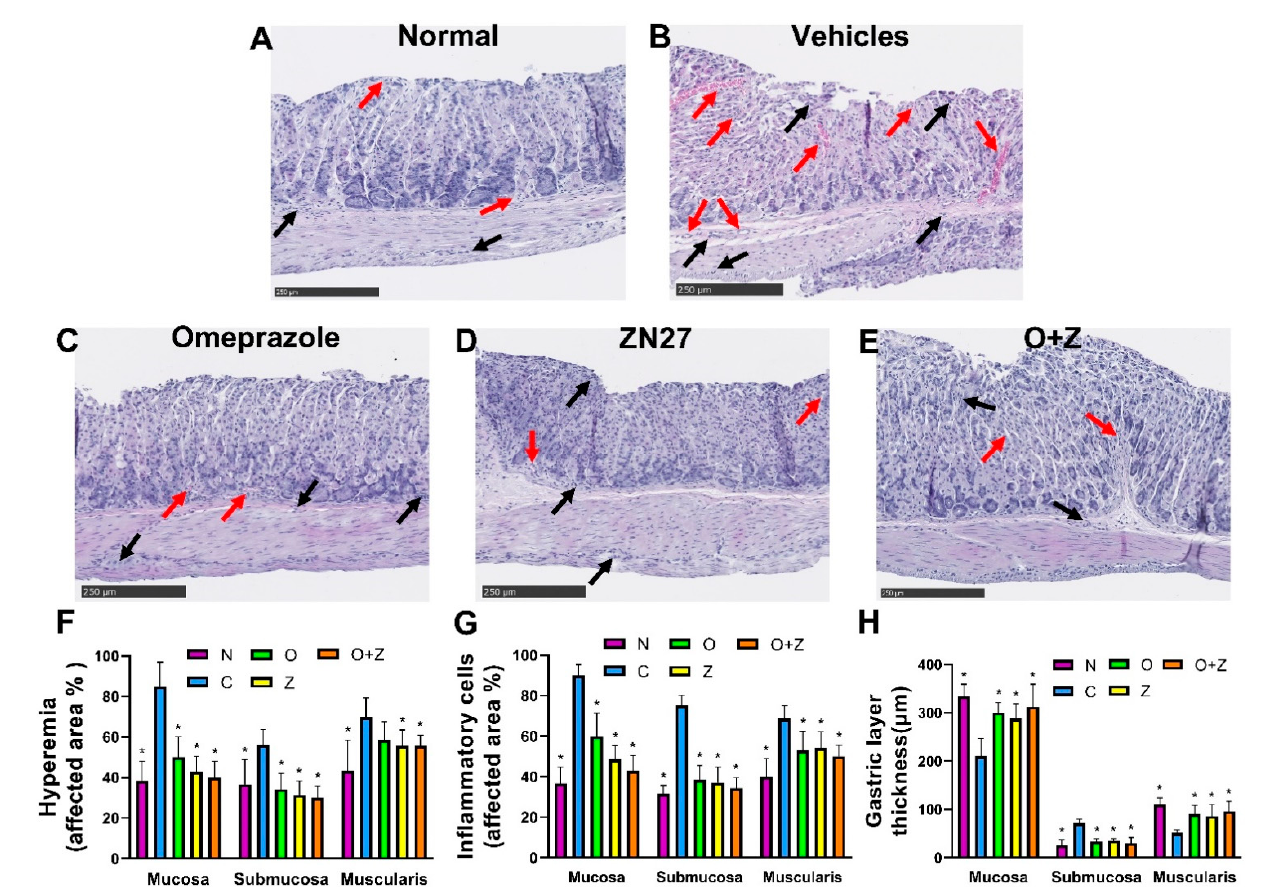
Figure 5. ZN27 decreases hyperemia and inflammatory cells and ameliorates the thickness of gastric layers in the ongoing aspirin-induced gastric injury model. Typical subsets of histologic fields that were scored positive for inflammatory cells and hyperemia/congestion in mice receiving no treatment ( A ), vehicles ( B ), 900µg/kg ZN27 ( C ), 10 mg/kg omeprazole ( D ), or omeprazole plus ZN27 ( E ) at day 6. Black arrows in the histologic images indicate inflammatory cells, and red arrows indicate hyperemia. For illustrative purposes, only partial fields are shown. The scale bar represents 250 µm. ( F , G ) Microscopic hyperemia and inflammatory cell infiltration scoring, respectively, in mice receiving vehicles ( n = 8), ZN27 ( n = 7), omeprazole ( n = 7), or omeprazole plus ZN27 ( n = 7) are compared with normal mice ( n = 6) at day 6, assessed morphometrically in 10 sections/mouse by a blinded observer. ( H ) Gastric layer thickness in mice receiving vehicles ( n = 8), ZN27 ( n = 7), omeprazole ( n = 7), or omeprazole plus ZN27 ( n = 7) are compared with normal mice ( n = 6) at day 6, assessed morphometrically in 10 sections/mouse by a blinded observer. * p < 0.05 vs. aspirin-injured vehicle controls. Scale bars, 250µm. Normal (N), vehicles (C), omeprazole (O), ZN27 (Z), and omeprazole/ZN27 (O + Z).